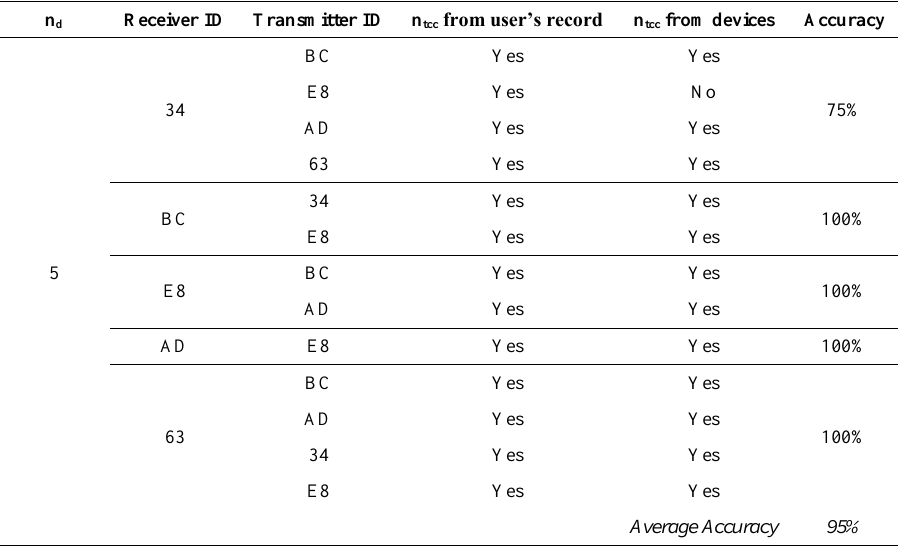
Table 5. Stage 3 Experimentation